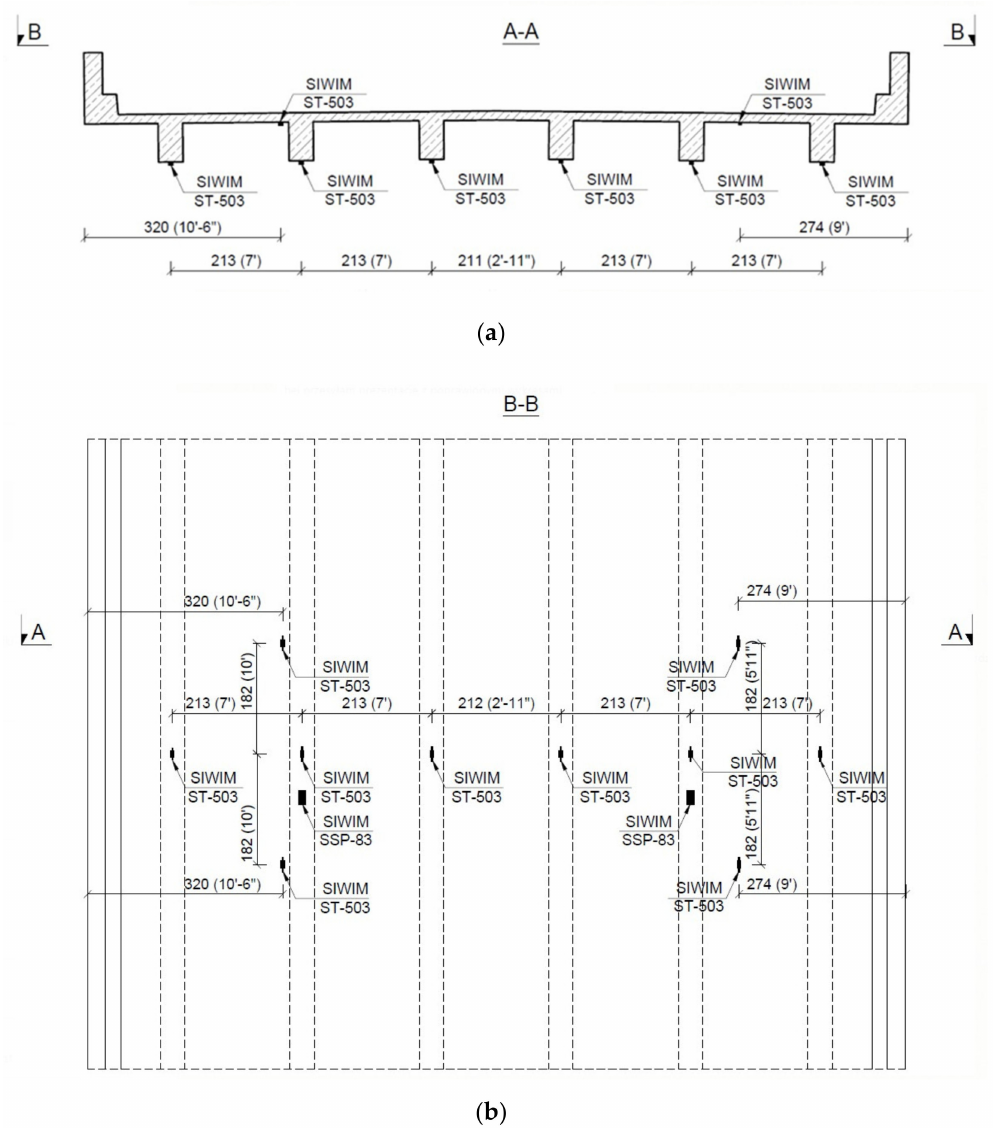
Figure 4. Considered truck weigh systems: ( a ) overview, ( b ) specific